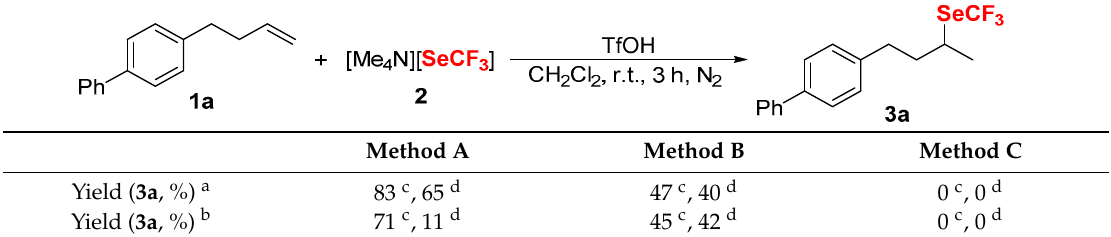
Table 2. The effects of charging sequence on the reaction.